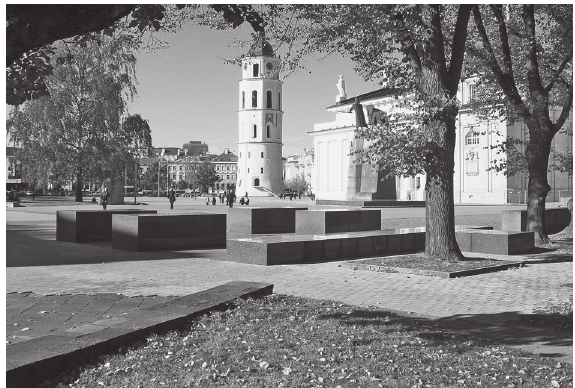
Fig. 5. The site of Castle gate, Cathedral Square in Vilnius,